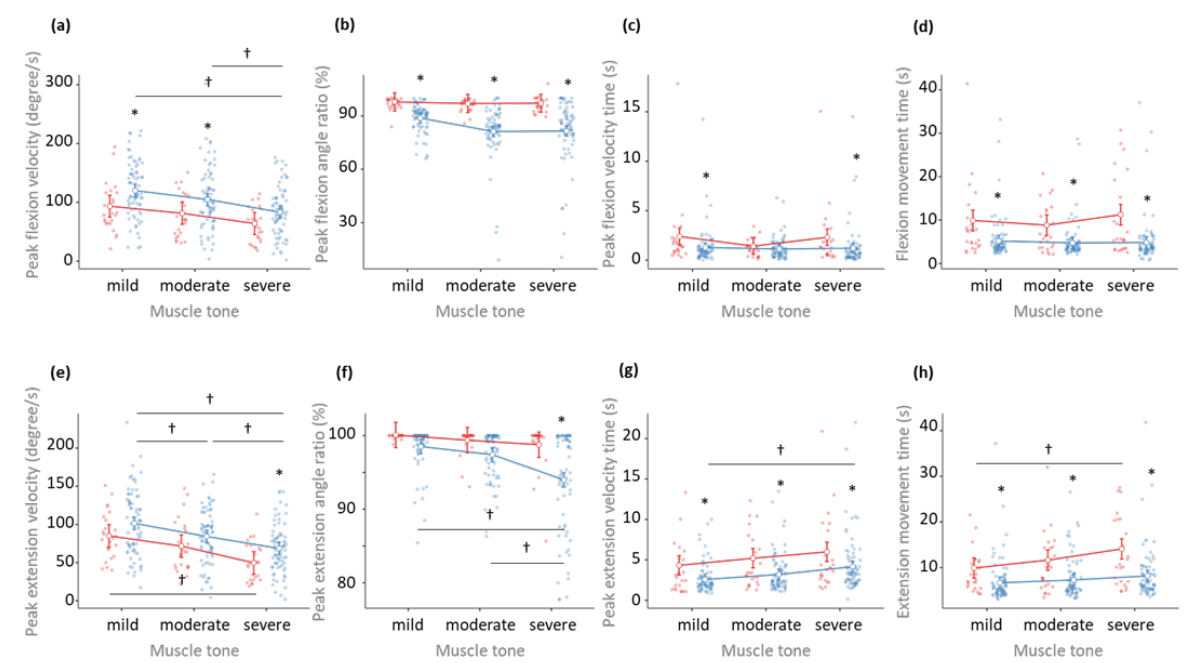
Figure 4. Comparison of therapeutic motion techniques based on subject and degree of muscle tone. ( a ) Peak flexion velocity; ( b ) peak flexion angle ratio; ( c ) peak flexion velocity time; ( d ) flexion movement time; ( e ) peak extension velocity; ( f ) peak extension angle ratio; ( g ) peak extension velocity time; ( h ) extension movement time. Red dots: therapists ( n = 8), blue dots: students ( n = 25). Therapists vs. students: * p < 0.05. Within group comparisons: † p < 0.05.